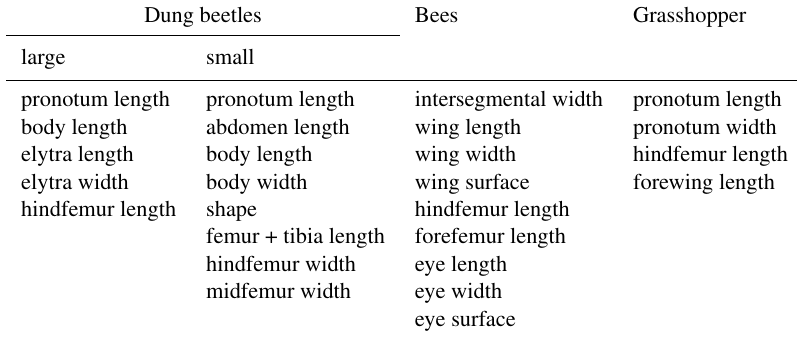
Table 2. Morphological traits measured for four insect groups. Dung beetles Bees Grasshopper large small pronotum length pronotum length intersegmental width pronotum length body length abdomen length wing length pronotum width elytra length body length wing width hindfemur length elytra width body width wing surface forewing length hindfemur length shape hindfemur length femur + tibia length forefemur length hindfemur width eye length midfemur width eye width eye